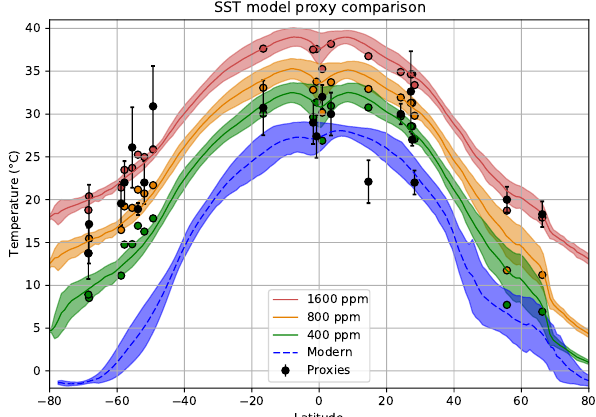
Figure 10. Comparison of model 1600ppm (red), 800ppm (or- ange) and 400ppm (green) simulations with a compilation of SST proxy data (black circles) from 38 to 34Ma (Baatsen et al., 2018a, Table A2). The compilation combines UK’ 37 , TEX 86 , Mg / Ca, δ 18 O and (cid:49) 47 data – see text for further references. The model tem- perature for each proxy location is shown by the coloured circles. The zonal mean and standard deviation are shown by the solid lines and shaded areas respectively. Also shown in blue is an equivalent distribution of the zonal mean and standard deviation from the mod- ern World Ocean Atlas (Locarnini et al.,